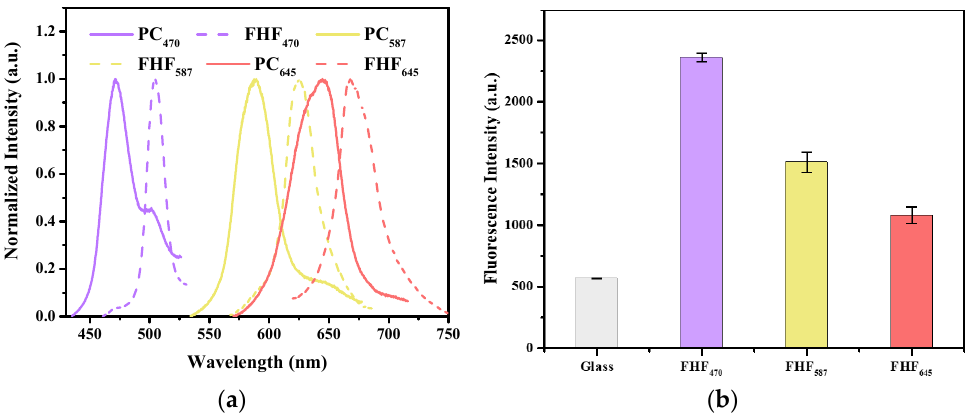
Figure 5. Reflectance spectra of photonic crystals and their corresponding fluorescent photonic crystal hydrogel films ( a ) and comparison of the maximum fluorescence intensity of the control film and the prepared hydrogel films with different stopbands of photonic crystal templates ( b ).